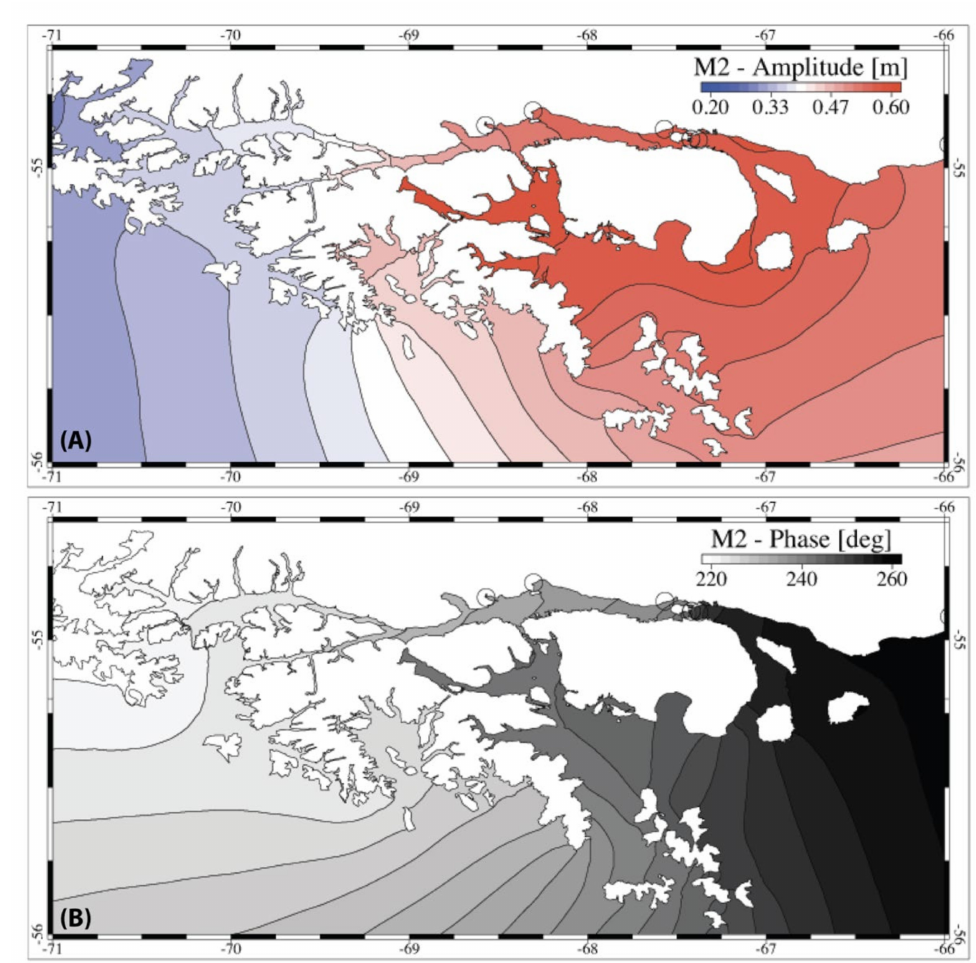
Figure A1. Modeled corange and cotidal maps for M2 in the BC and surroundings: corange lines in m ( A ) and cotidal lines in degrees ( B